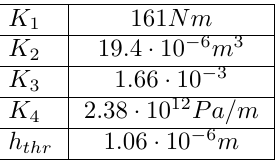
figure 12. The constant term is very dominating.